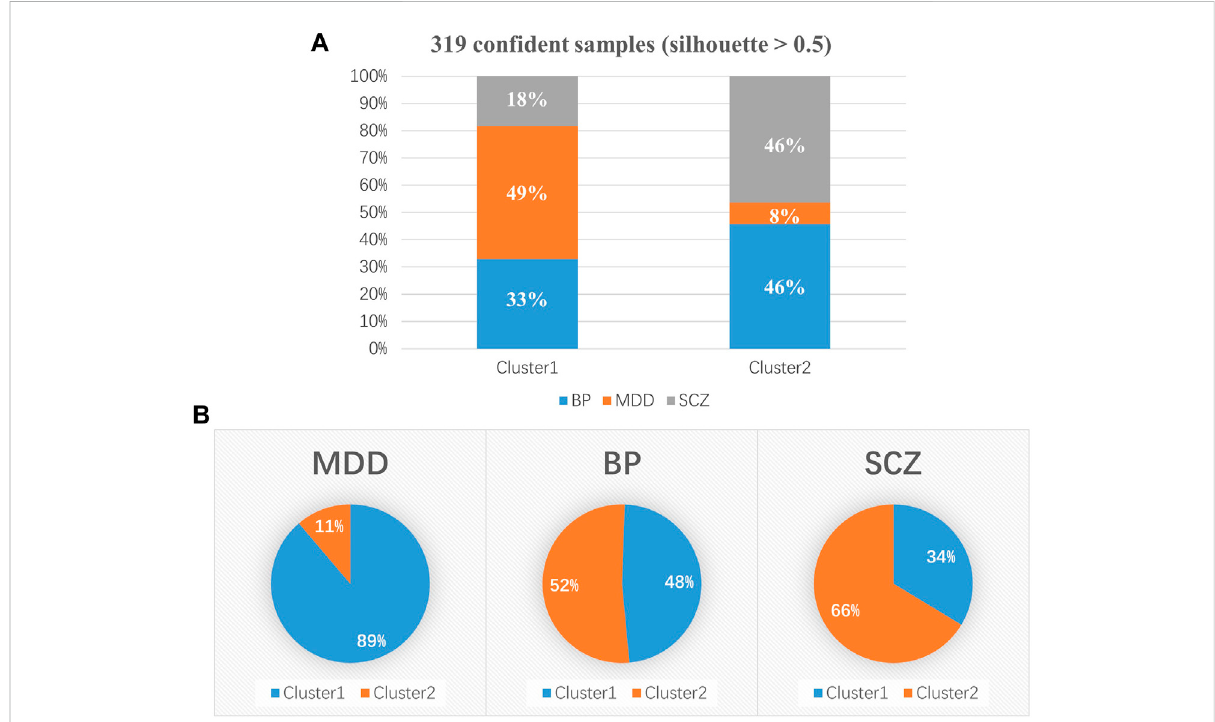
FIGURE 3 Distribution of clinical diagnoses in the two subgroups. (A) Cluster 1 included 179 psychiatric patients, consisting of 33 (18%) patients with SCZ, 59 (33%) patients with BP and 87 (49%) patients with MDD, and Cluster 2 included 140 psychiatric patients. (B) A higher proportion of MDD patients was present in Cluster 1 (89%) than in Cluster 2 (11%). There were more patients with SCZ in Cluster 2 (66%) than in Cluster 1 (34%). Patients with BP wereuniformly distributed inCluster1(52%)andCluster2(48%).SCZ,schizophrenia; BP,bipolardisorder;MDD,depressive disorder. * p < 0.05; ** p < 0.01; *** p <